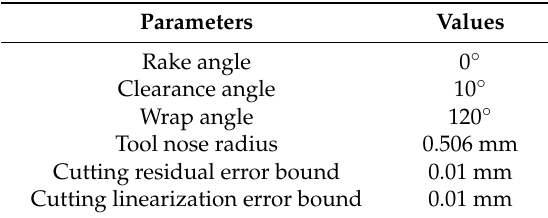
Table 2. Diamond tool parameters and error restraint value.